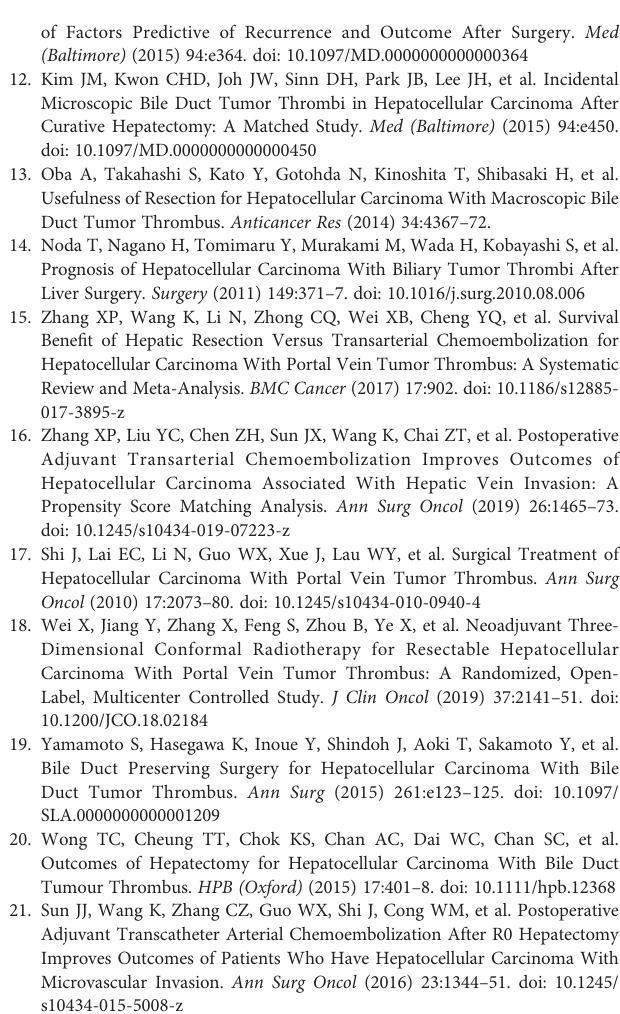
Supplementary Figure S1 | Subgroup analysis of MOST strati fi ed by potential risk factors before and after PSM. MOST, median overall survival time; LR, liver resection; TACE, transcatheter arterial chemoembolization; PSM, propensity score matching; CI, con fi dence interval; HBsAg, hepatitis B surface antigen; HGB, hemoglobin; ALB, albumin; TBIL, total